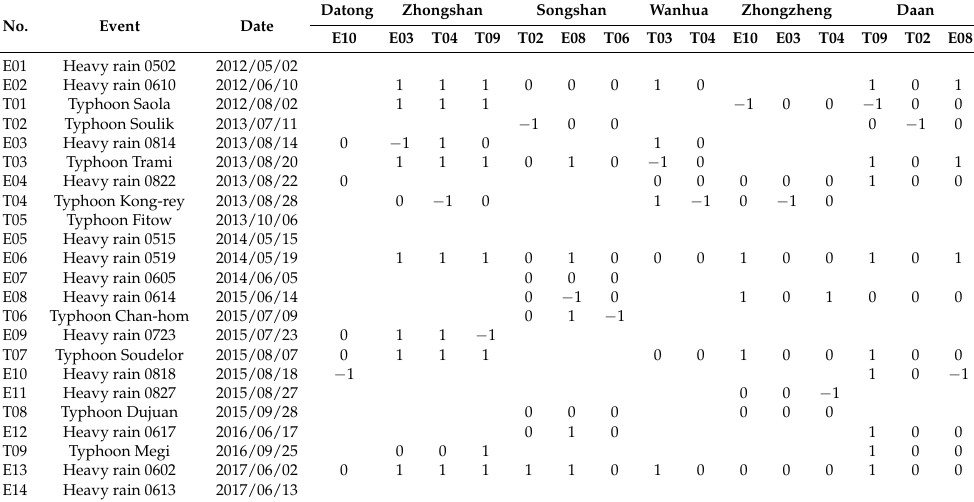
Table 7. Warning process results of the cross test for the six districts with partial flood